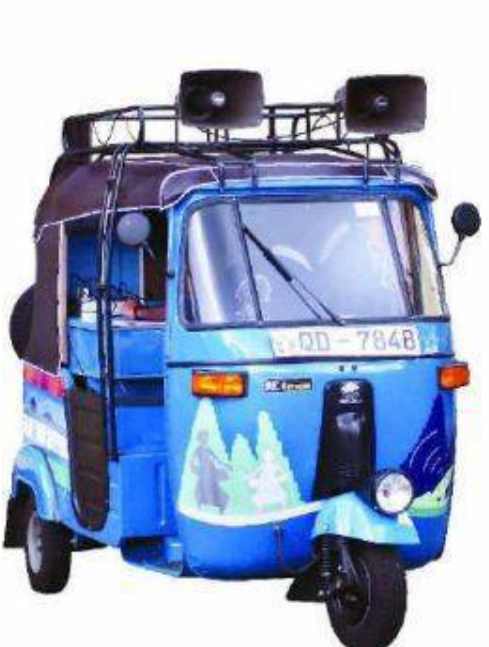
Figure 1 . The e-tuktuk, an autorickshaw that serves as a mobile radio station and multimedia centre. Source: Google